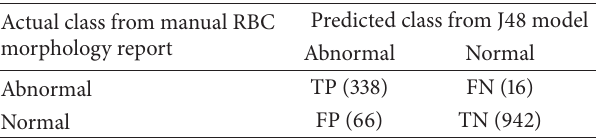
Table 3: The confusion matrix of predicted RBC morphology by J48